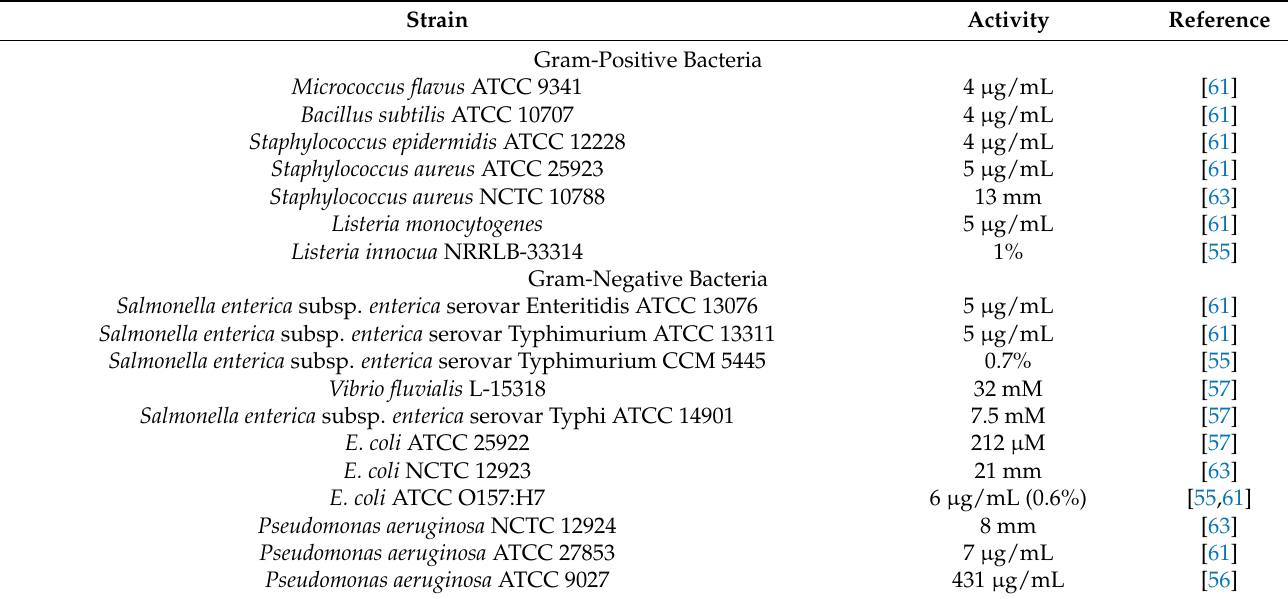
Table 2. Antimicrobial activity of linalool against